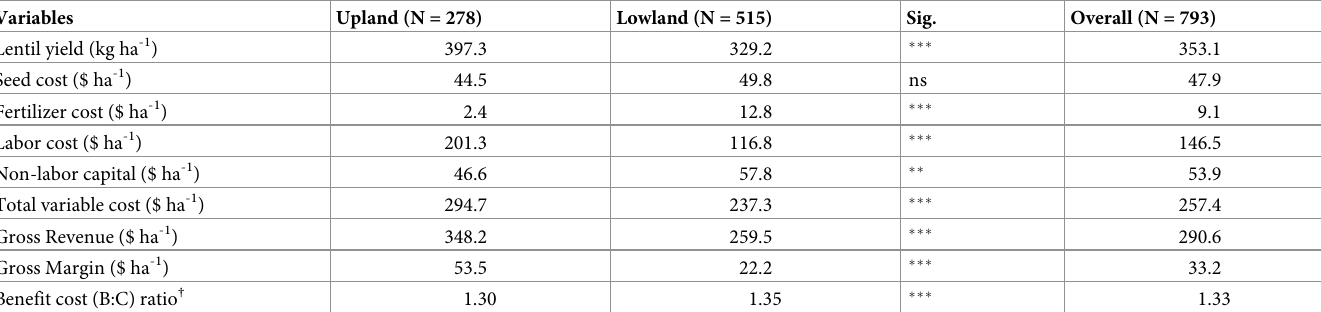
Table 2. Lentil production characteristics differentiated by production ecologies.